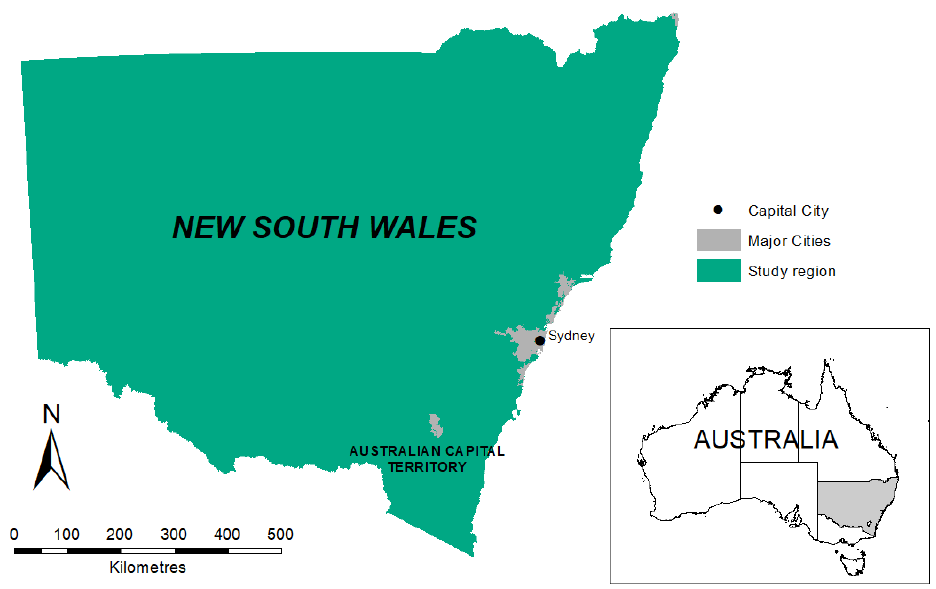
Figure 1. Study region—non-metropolitan New South Wales (NSW), Australia.